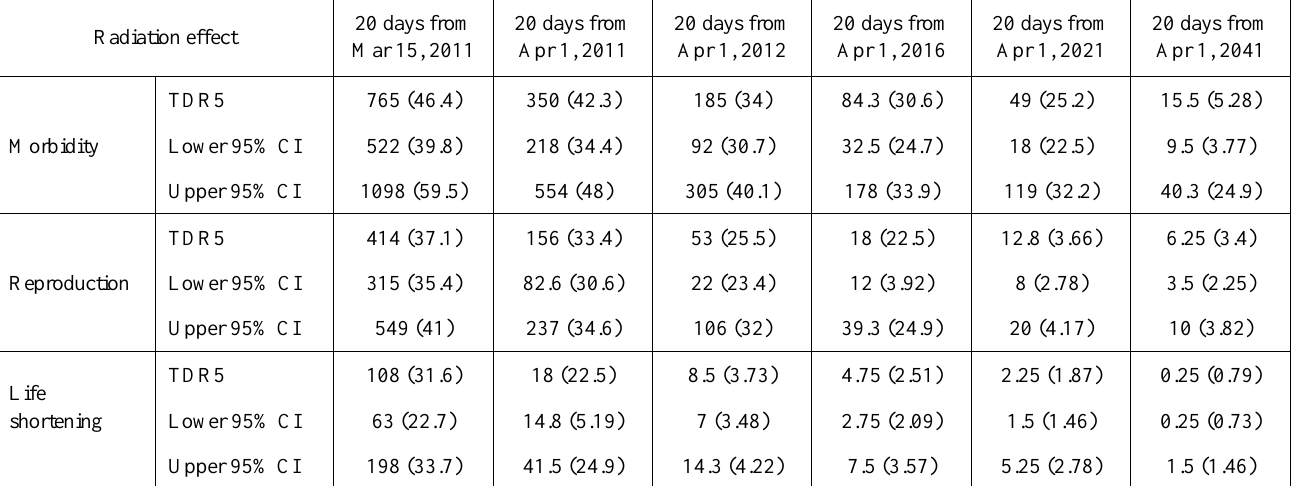
Table 2. The predicted area (km 2 ) of radiation effects on vertebrates. The maximum distance (km) from Fukushima Daiichi NPP is in